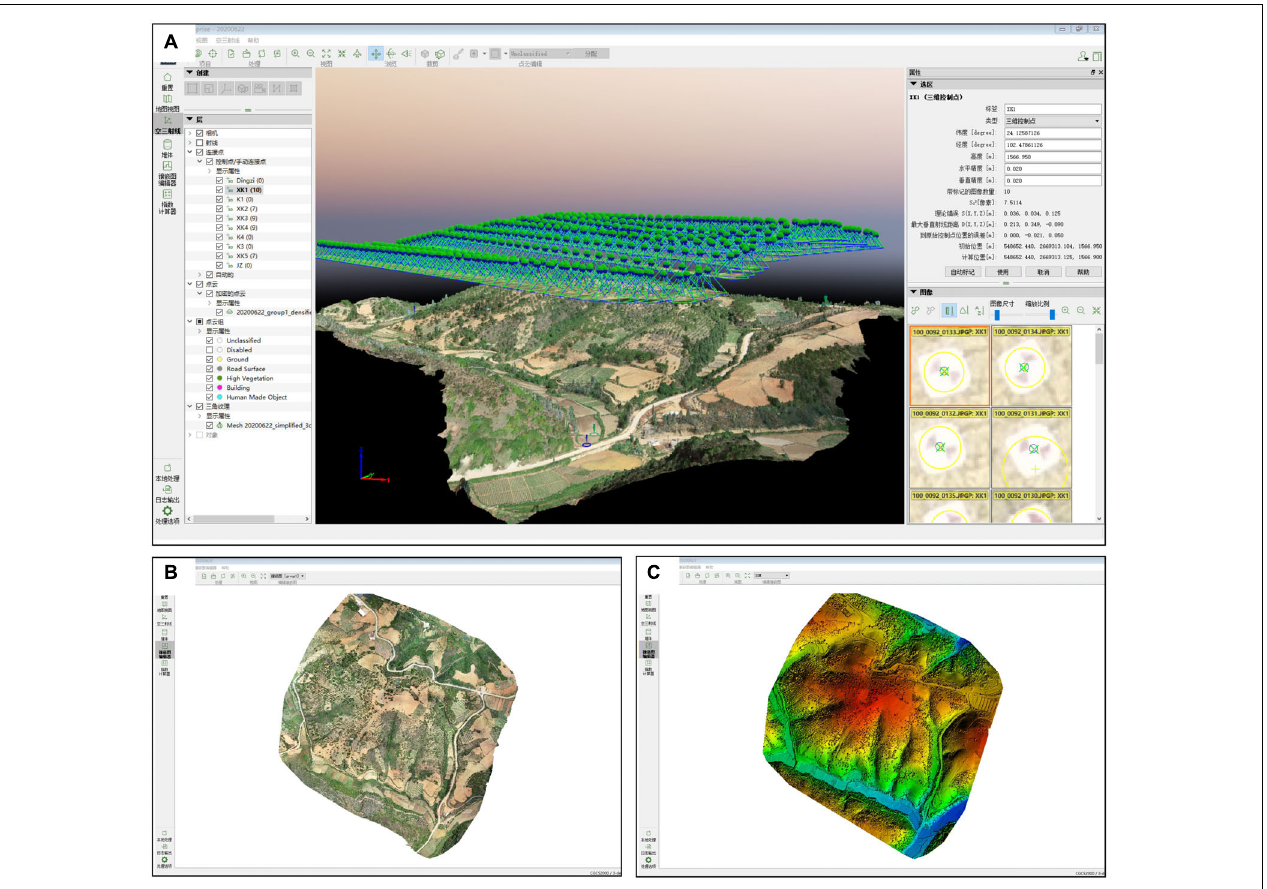
FIGURE 6 | Screenshots of UAV data processing: (A) Pix4D working window, (B) DOM generated by Pix4D, and (C) DSM generated by Pix4D.